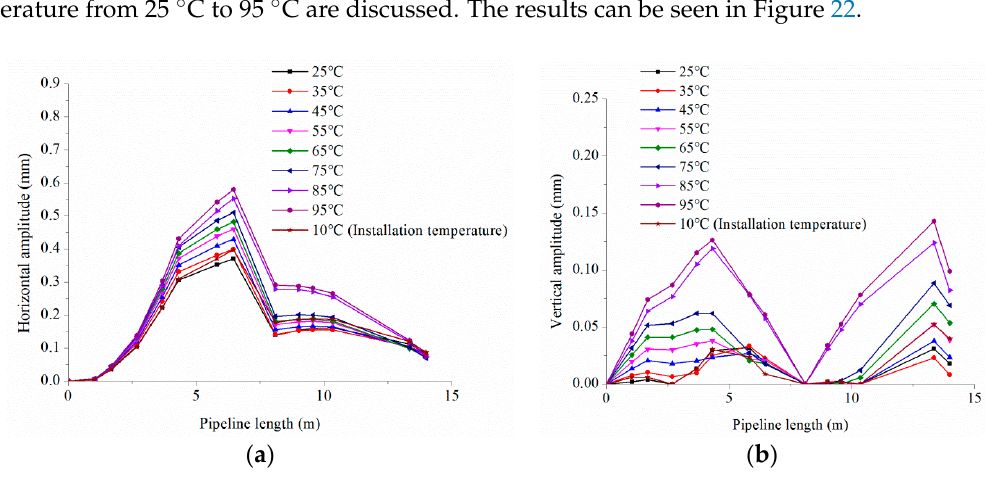
Figure 22. Amplitude distribution of RP1 pump outlet pipe at different temperatures: ( a ) horizontal amplitude; ( b ) vertical amplitude.